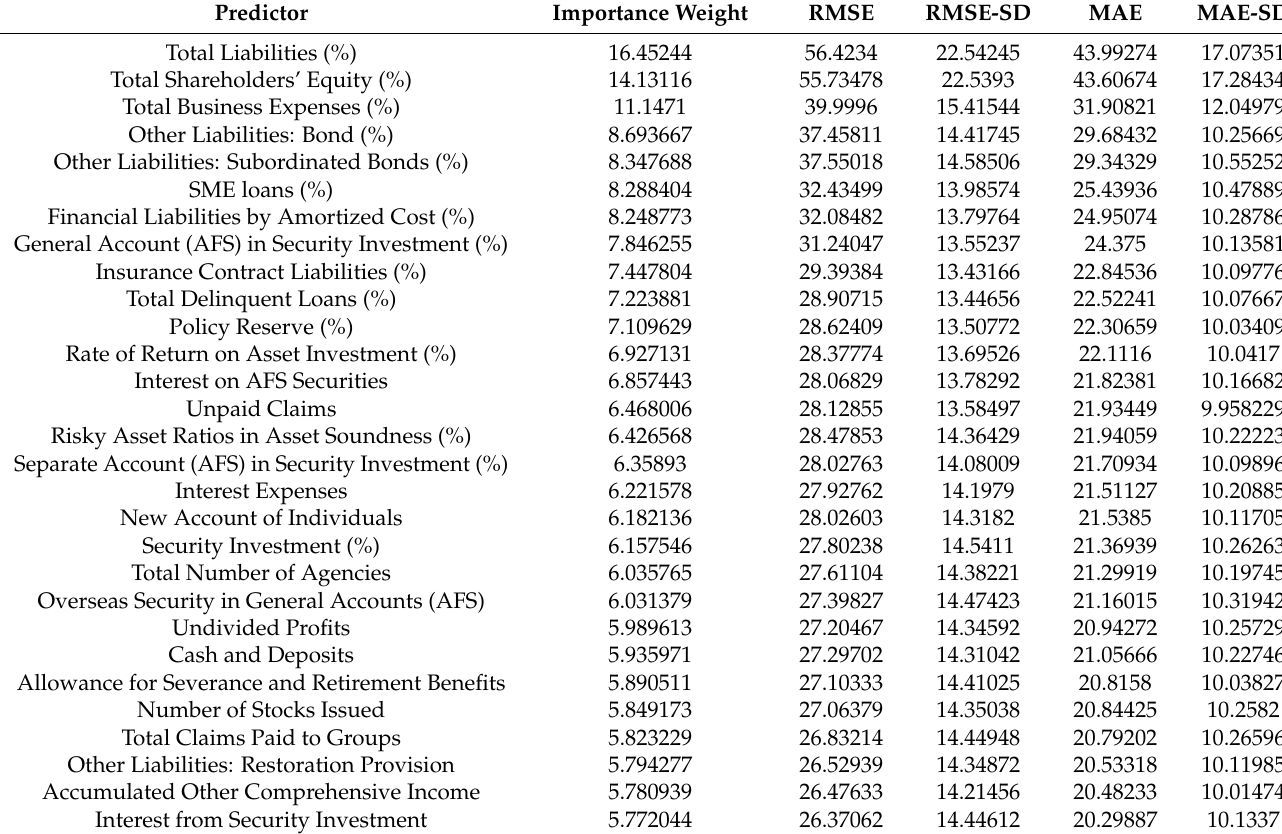
Table 3. 29 Important Predictors According to Random Forest